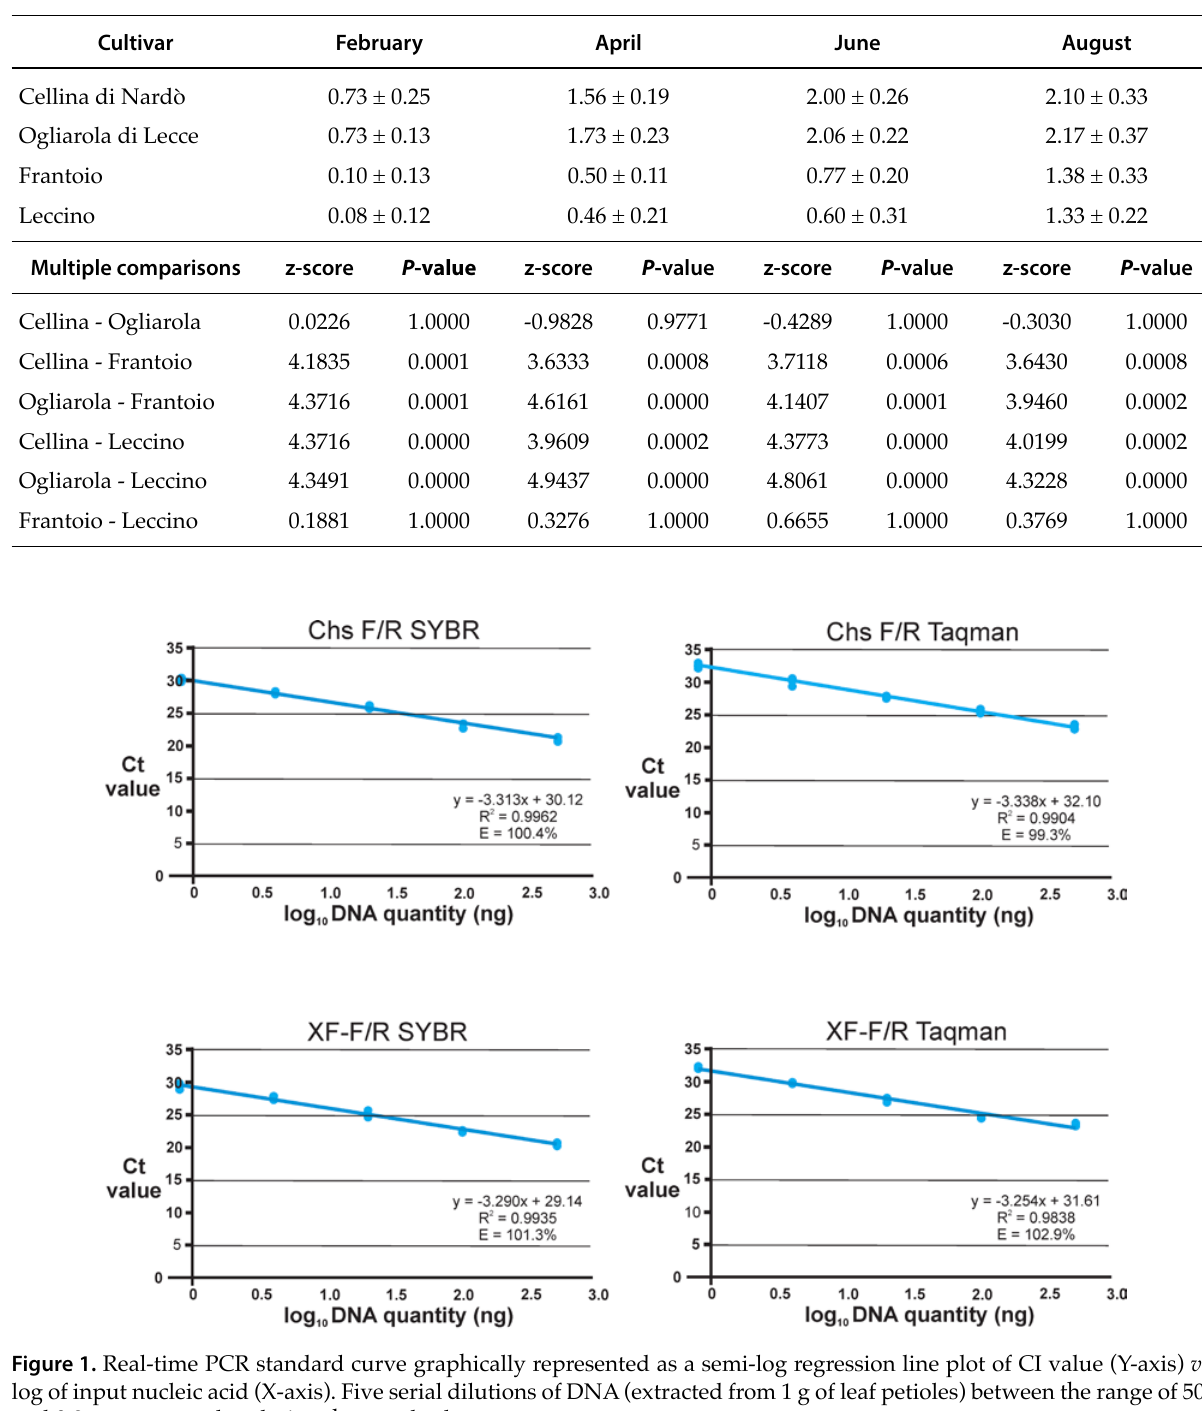
Table 1. Disease progression in four olive cultivars, expressed as mean disease severity scores based on a visually assessed scale from 0 to 3. Observations were assessed 2, 4, 6 and 8 months after pruning. The data comprised an average of 12 Xylella fastidiosa subsp. pauca ( Xfp ) infected plants per cultivar.